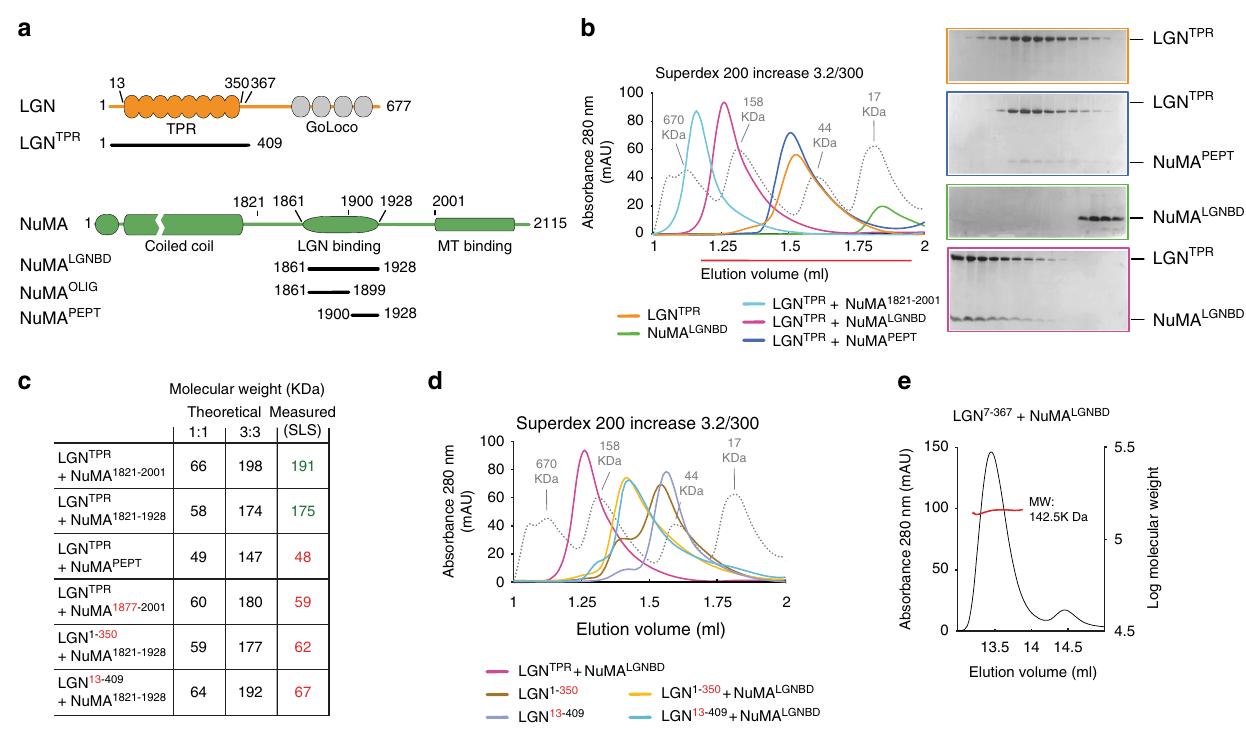
Fig. 1 LGN and NuMA engage into high-molecular weight oligomers. a Cartoon representation of LGN and NuMA domain structures. Bold lines with numbers indicate protein subdomains being used in the in vitro binding assays. b SEC elution pro fi les of LGN TPR (20 μ M) in complex with NuMA 1821 – 2001 (20 μ M), NuMA LGNBD (20 μ M) or NuMA PEPT /NuMA 1900 – 1928 (40 μ M). The run of globular molecular weight markers is indicated in gray. The early elution volume of LGN TPR :NuMA LGNBD indicates they form higher molecular species compared with the 1:1 stoichiometric LGN TPR :NuMA PEPT / NuMA 1900 – 1928 dimer. Coomassie-stained SDS-PAGE in color-coded boxes show the protein composition of each elution pro fi le. c Table of static light scattering (SLS) experiments conducted with the trimmed LGN:NuMA constructs used in Fig. 1b – d, and Supplementary Fig. 2a, b. SLS measurements shown in green indicate oligomerizing complexes, while red values belong to oligomerization-de fi cient LGN:NuMA pairs. d SEC analyses conducted with LGN TPR truncations and NuMA LGNBD . The oligomerization determinants span residues 1 – 12 and 351 – 409 on LGN. e SLS analysis indicating that the LGN 7 – 367 and NuMA LGNBD engage in 142.5kDa oligomers compatible with a 3:3 stoichiometry. This also suggests that LGN 7 – 367 is the minimal oligomerization domain of LGN central triangular cavity re fl ecting the threefold symmetry of the Table 1 Data collection and re fi nement